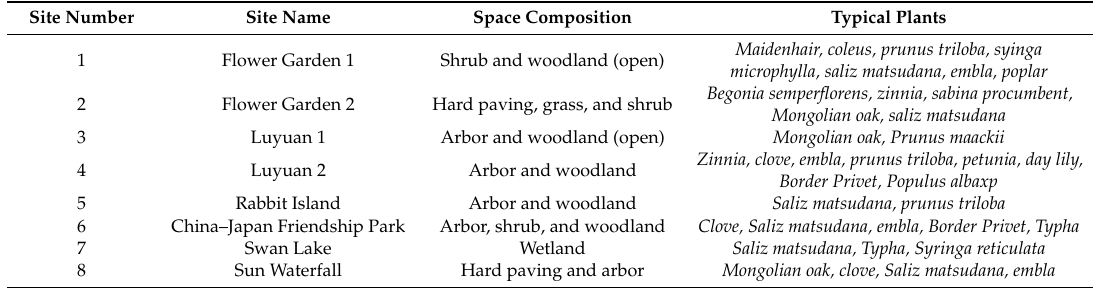
Table 1. Space composition and typical plants for eight sites in Sun Island